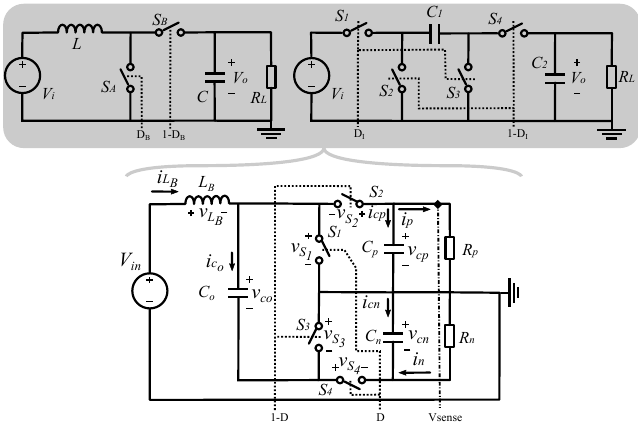
Figure 2. Topology of the proposed SIBO Boost converter.